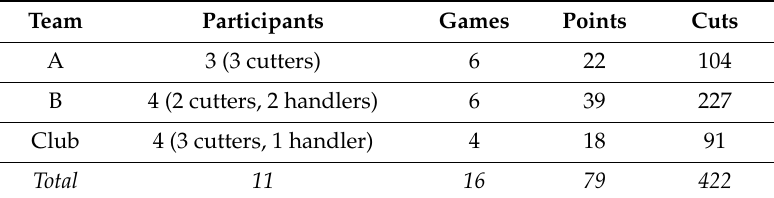
Table 1. Total values for each